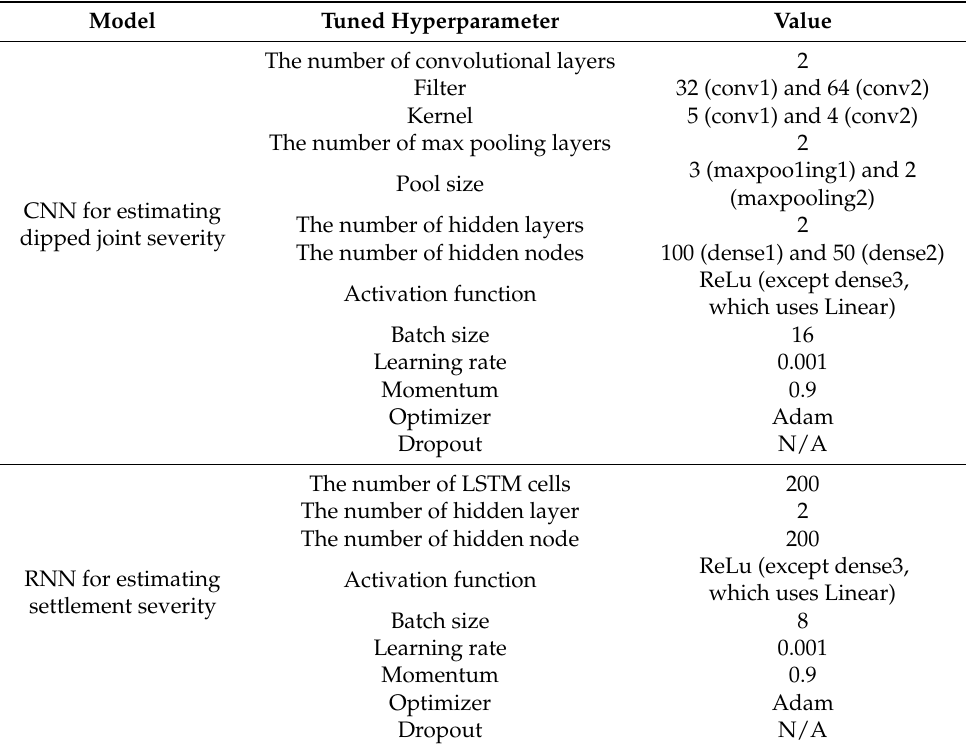
Table 14. List of tuned hyperparameters for estimating the combined detect severity.